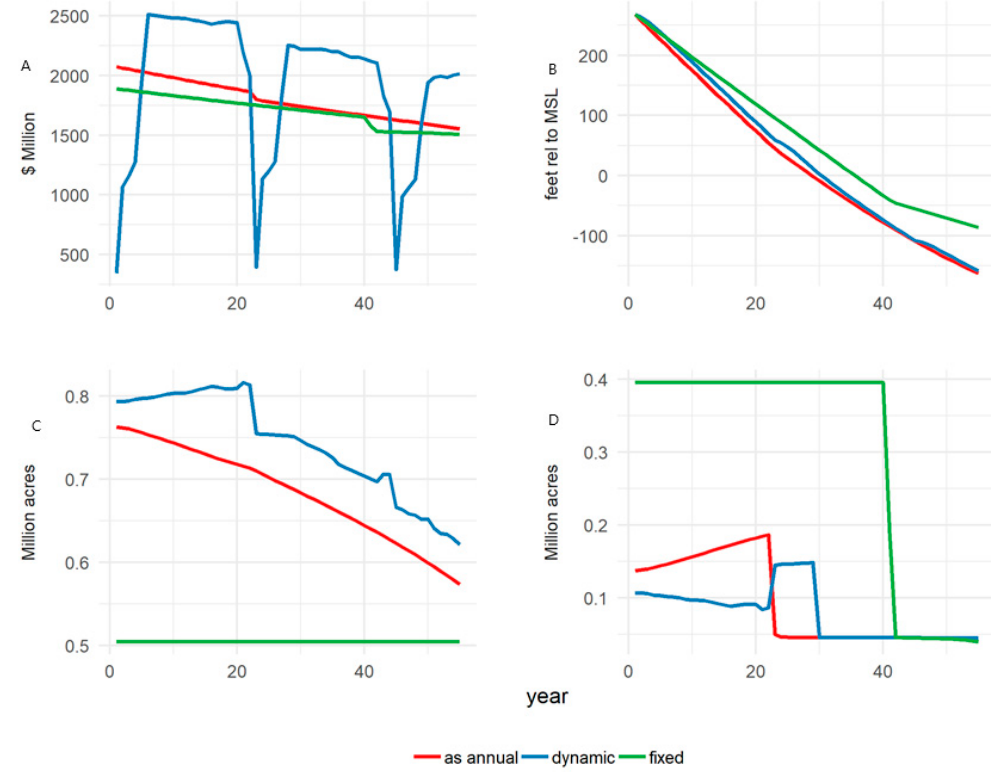
Figure 7. Model comparison for key time series in the “low water, high price” scenario. ( A ) annual net benefits, ( B ) aquifer height, ( C ) perennial area, and ( D ) annual area.